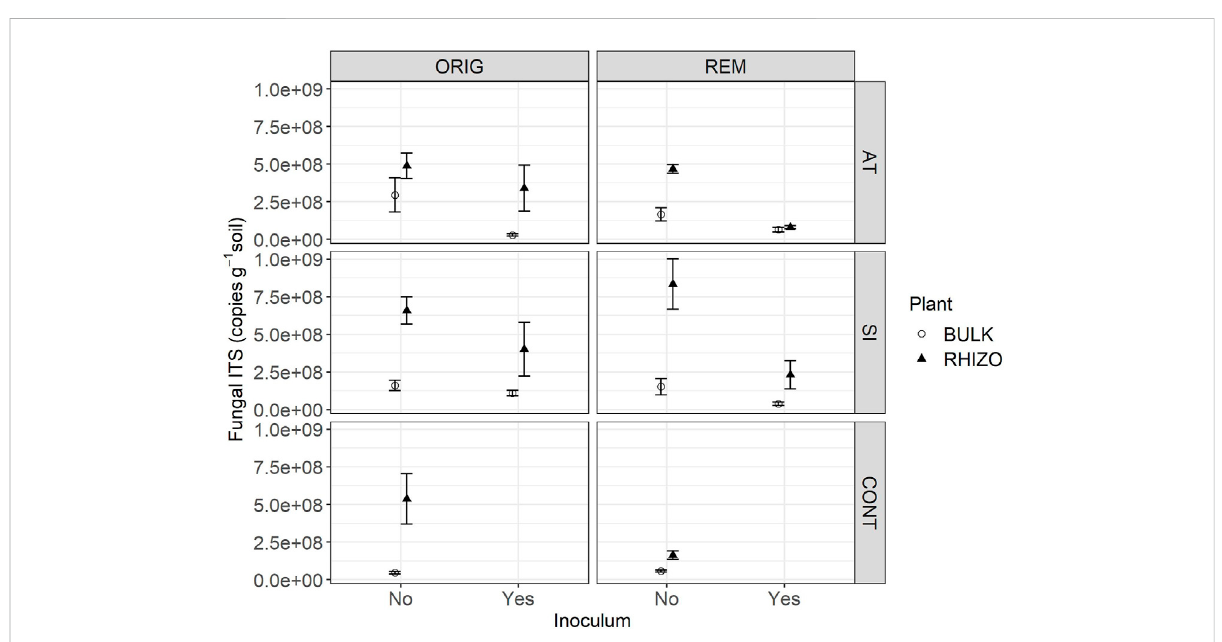
FIGURE 1 Fungal ITS abundancein Austrian (AT), Slovenian (SI)and control (CONT) soil, before (ORIG) and after remediation (REM). Soilfrom mesocosms was sampled 4 months after the addition of plants seeds and indigenous inoculum (rhizosphere soil and roots from a grassland) (2 November 2016). Mean ± SE of four replicates is